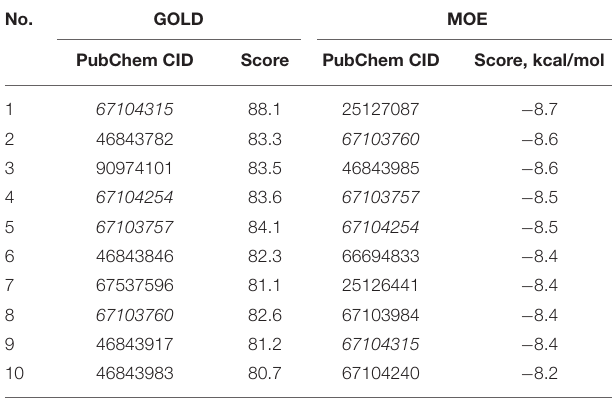
TABLE 1 | Scores for the ATP and the ATP-competitive type I kinase inhibitors obtained from the docking performed by the GOLD, MOE, and AutoDock software.